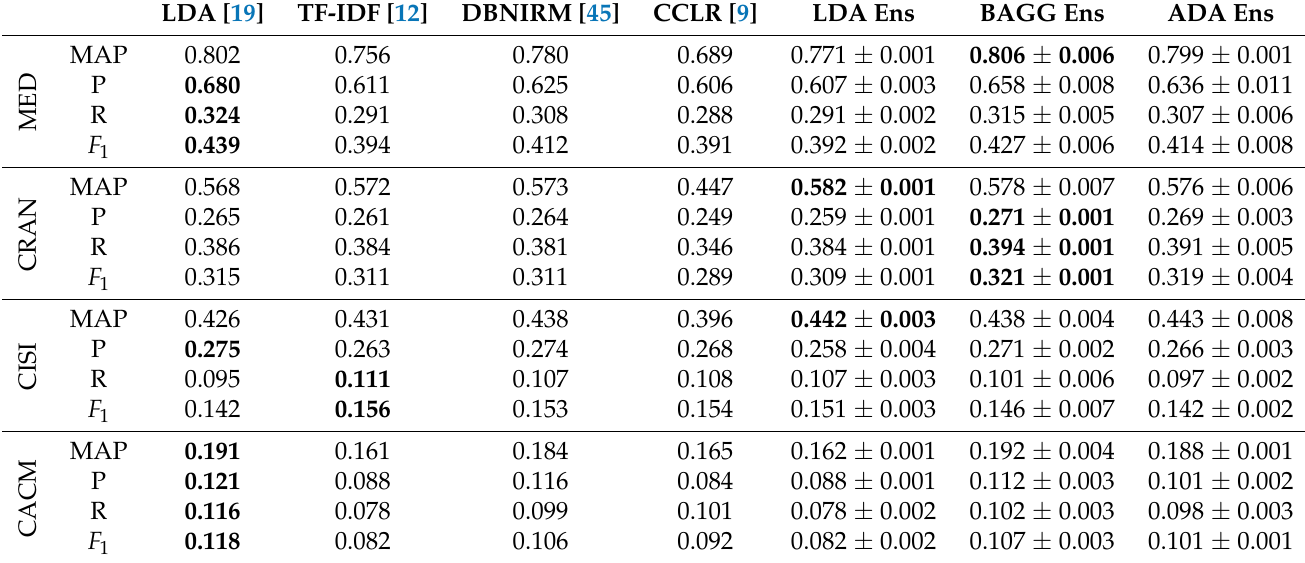
Table 4. Results reported using @10 lists.